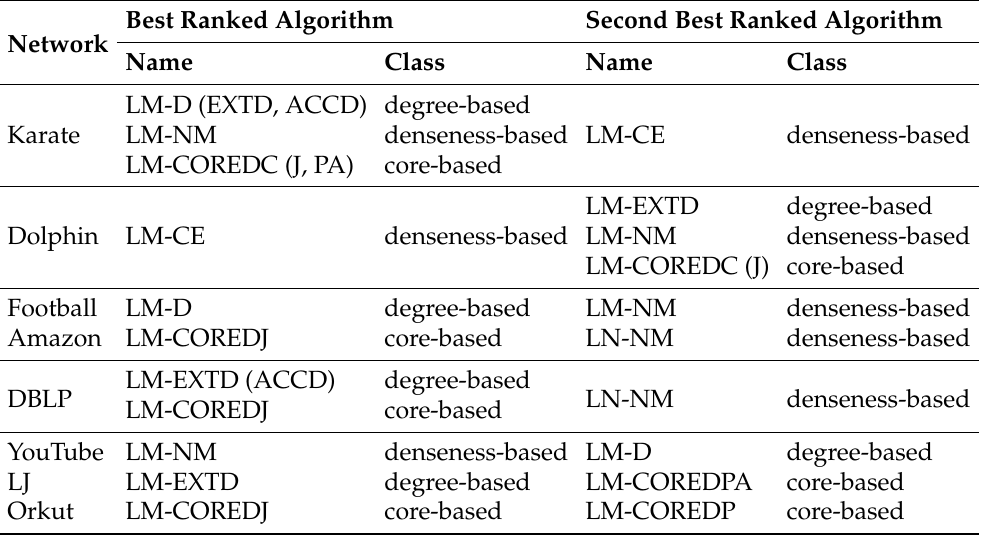
Table 8. The best and second best ranked algorithms. Best Ranked Network